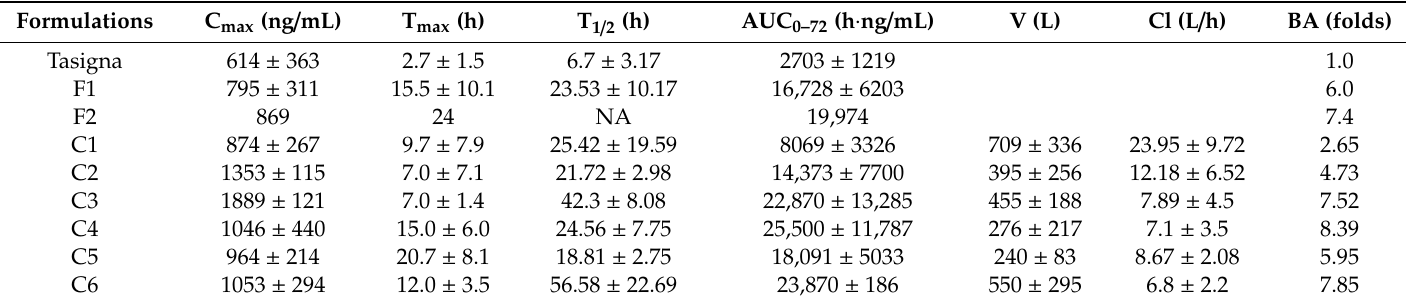
Table 7. Pharmacokinetics parameters of di ff erent formulations of nilotinib in rabbits (mean ± standard deviation, n = 2 or 3).